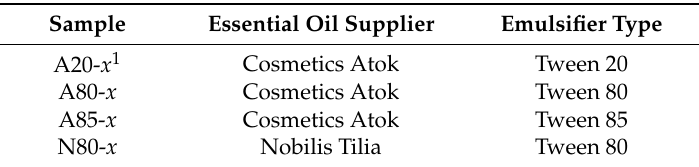
Table 1. Designation of